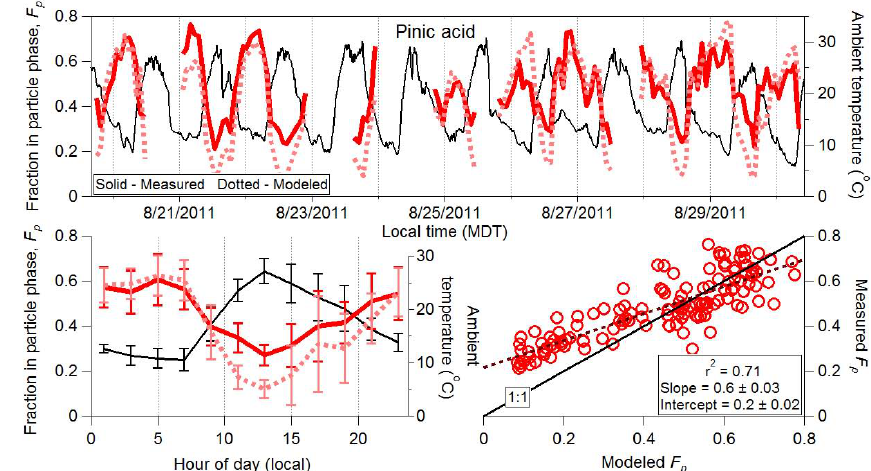
Fig. 13. Time series, diurnal cycle, and scatter plot of measured and modeled F p for C 9 H 13 O −